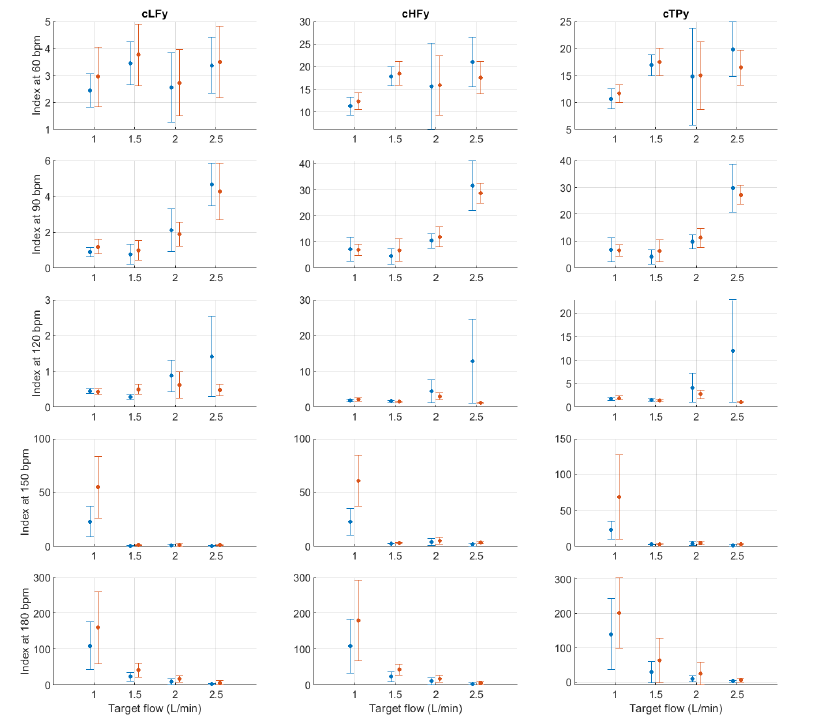
Figure A12. Mean and standard deviation of the y -coordinates of the centroid-related indices ex- tracted from pulse rate variability under different stroke rates (SR) and target flows (TF, TF below 2.5 L/min) conditions, and measured from the radial (blue) and deep palmar arch (orange)